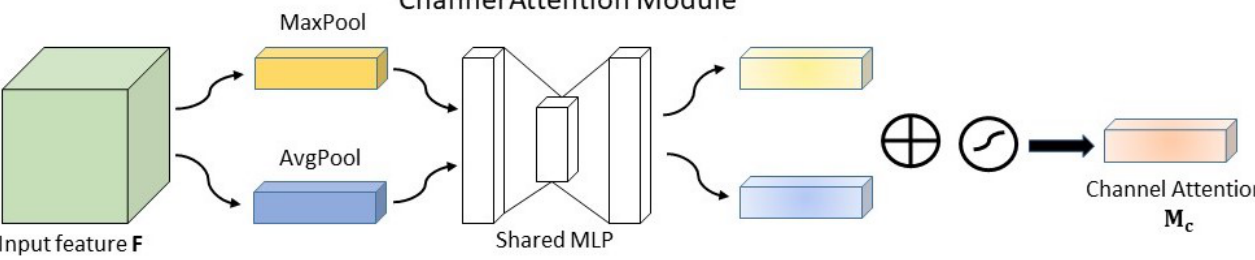
Figure 3. Channel attention